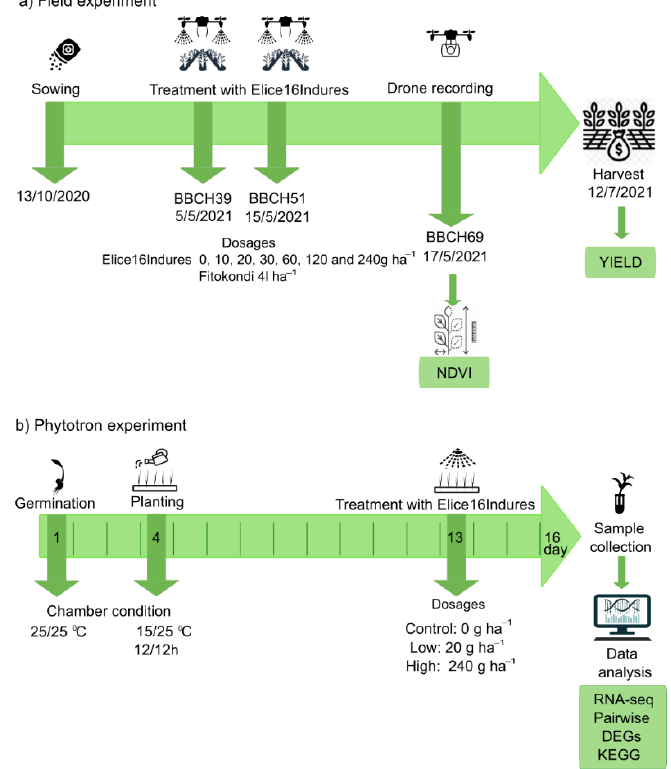
Figure 10. Design of field and phytotron experiments. Green rows indicate the timeline of plant cultivation, plant phenophases, treatments, harvest, and sample collection of autumn barley in the field ( a ) and phytotron ( b ) experiments. Green boxes indicate which measurements were performed in the experiments.